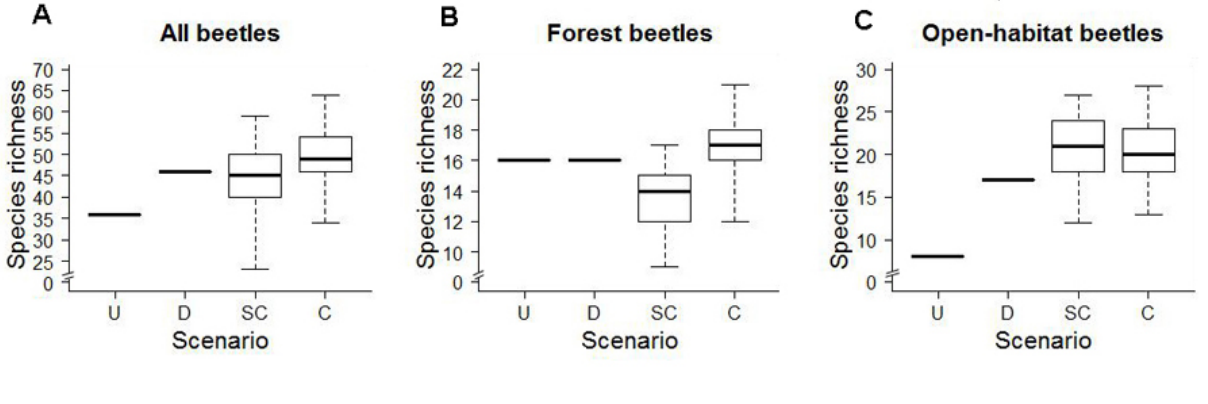
Fig. 6 . The estimated species richnesses of three carabid beetle groups in four hypothetical development scenarios: U, Undeveloped; D, Dispersed; SC, Semi-compact; C, Compact. (A) All beetles. (B) Forest beetles. (C) Open-habitat beetles. The species included in each group are given in Appendix 2. The lower edge of each box is the first quartile, the bold center line is the median, and the upper edge is the third quartile of the distribution. Whiskers extend to the minimum and maximum values. Species richness estimates for the Undeveloped and Dispersed scenarios had zero variance. This is because every beetle species collected in the four Forested survey sites (for the Undeveloped scenario) and the four Exurban survey sites (for the Dispersed scenario) was always estimated to be in at least one of the large number (91.83) of replicate site areas in these